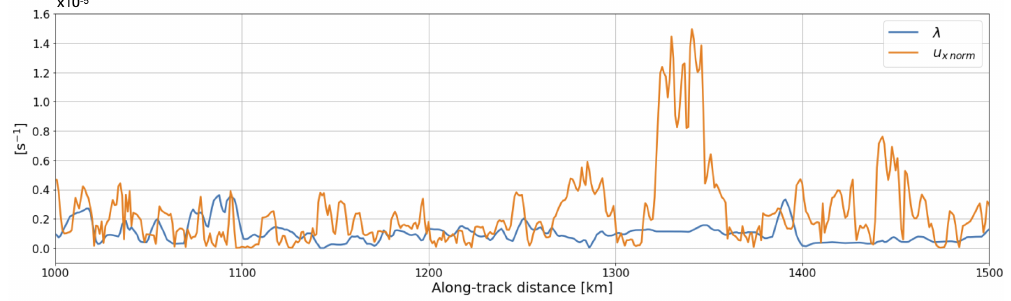
Figure 13. Time series of λ (blue curve) and u x norm (orange curve) along the seal’s